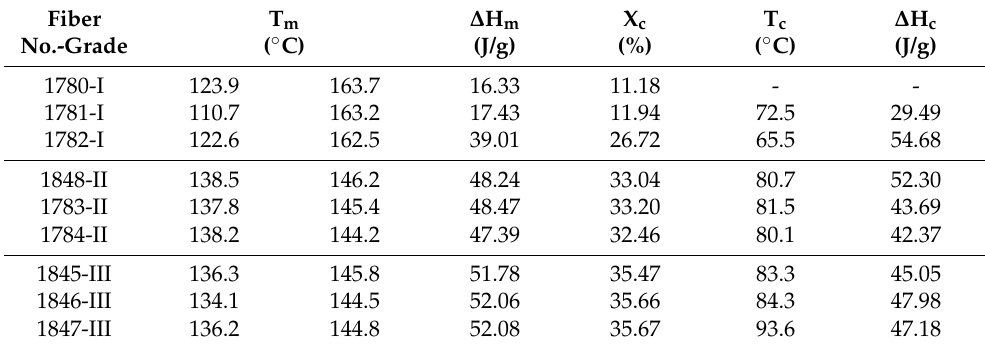
Table 5. Thermal properties of PHBH